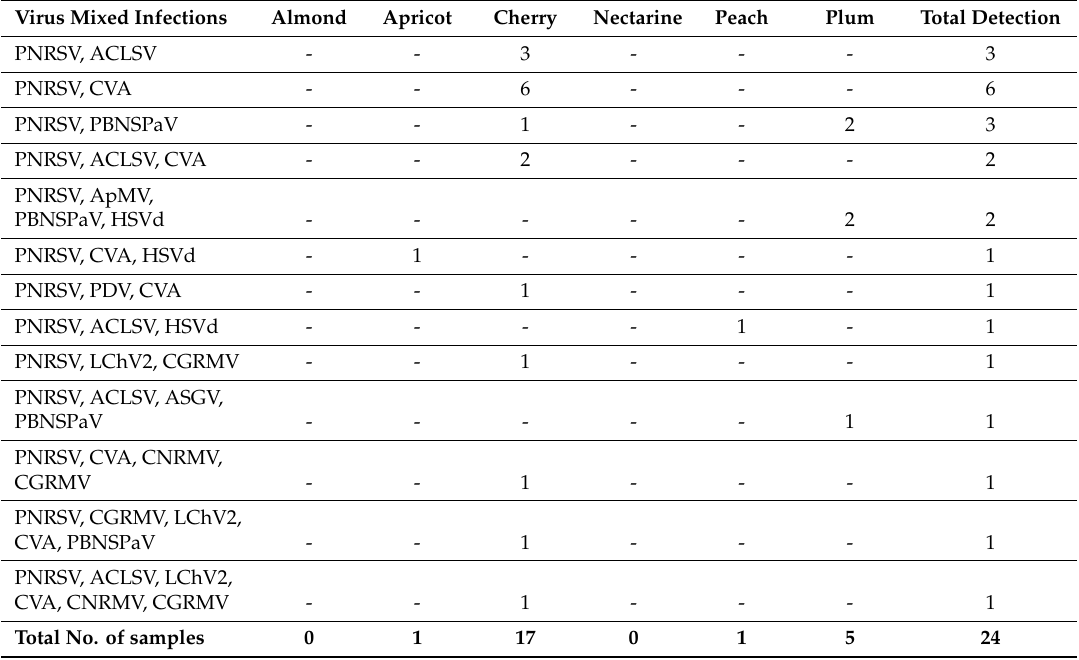
Table 3. The number of each of the Prunus trees in which mixed infections of viruses were detected by RT-PCR tests, the total number of samples and detections of each combination of viruses are shown. Virus Mixed Infections Almond Apricot Cherry Nectarine Peach Plum Total Detection PNRSV, ACLSV - - 3 - - - 3 PNRSV, CVA - - 6 - - - 6 PNRSV, PBNSPaV - - - -